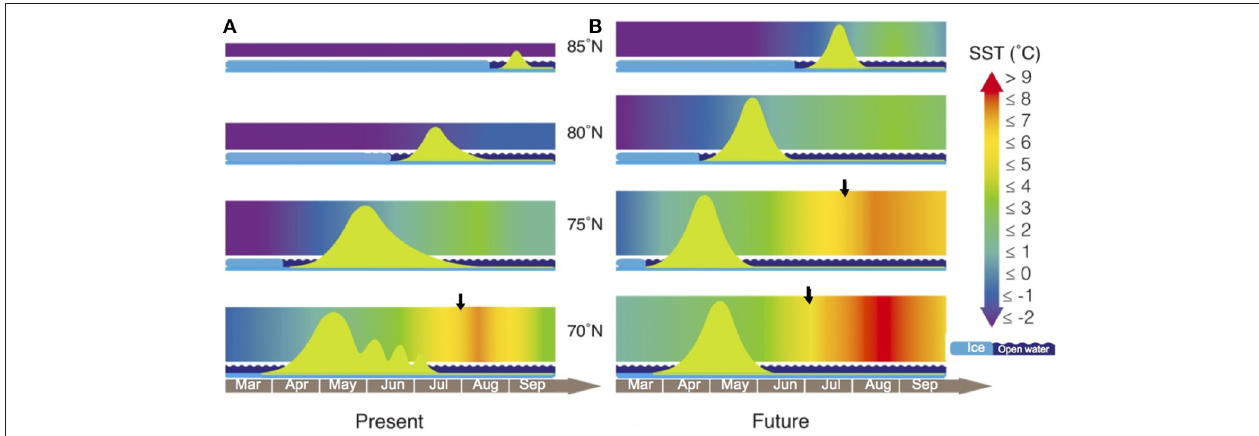
FIGURE 6 | SSTs and phytoplankton blooms in the Arctic at present and in future scenarios. Arctic phytoplankton blooms (green curves) develop in open waters (wavy dark blue bars) once sea ice retreats (light blue bars). Shaded areas represent daily changes in average SST. (A) Recent scenario, temperatures in the Arctic corresponding to 2013 (www.ncdc.noaa.gov) between 70 and 85 ◦ N. (B) The future SST scenario expected by 2100, assuming a 3 ◦ C increase in mean temperatures (right panel) and predicting sharper bloom developments due to faster growth rates at increased temperatures. Black arrows indicate when SSTs increase above the T OPT = 6.5 ◦ C. Modified after Wassmann and Reigstad (2011) and Leu et al.